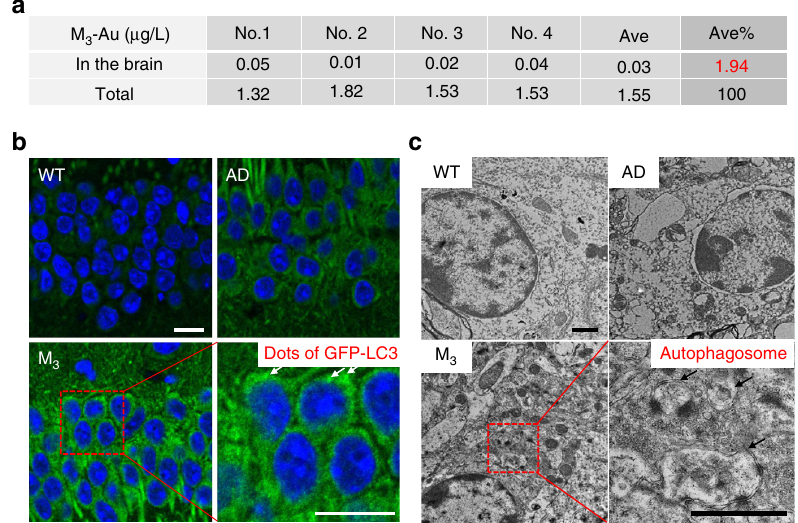
Fig. 7 In vivo evaluation of M 3 crossing BBB and activating autophagy. a The concentration of Au in the brain and in the total injection solution, respectively. The amount of M 3 actually reached to the brain was evaluated by Au amount: M 3 % = 0.03/1.55× 100% = 1.94%.( n = 4). b CLSM images and c bio-TEM images of brain tissue slices of AD mice treated by PBS or M 3 , and WT mice treated with PBS as a control. The dots of GFP-LC3 (white arrow in b ) and the strucuture of autophagsome (black arrow in c ) were pointed out in M 3 treated AD mice, respectively. Scale bar in ( b ) is 20 µ m. Scale bar in ( c ) is 1 µ